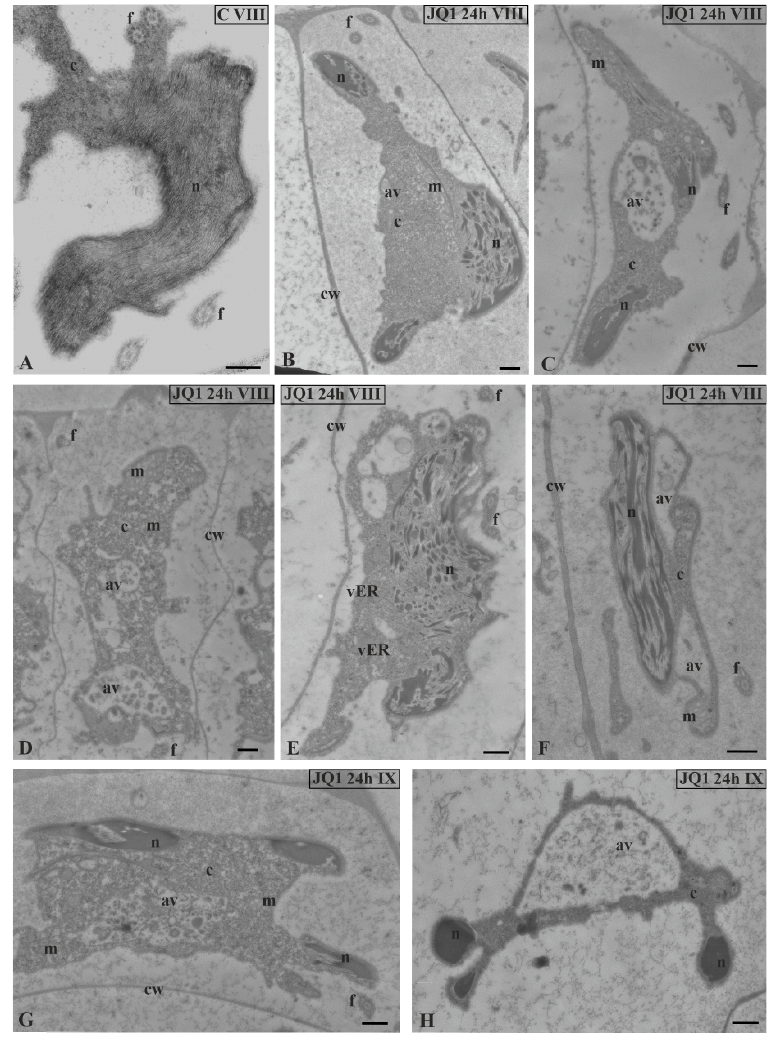
Figure 8. The effect of JQ1 on C. vulgaris spermatid ultrastructure at stages VIII ( B – F ) and IX ( G , H ) after 24-h JQ1 treatment; ( A ) the control, nucleus with long parallel chromatin fibrils; ( B , C , E – G ) disturbances in chromatin structure, and shorter or longer chromatin fibrils in the form of clusters separated by brighter areas; ( C – H ) changes in the cytoplasm area, numerous vesicles and large autolytic vacuoles containing fragments of cytoplasm; ( H ) spermatid with correctly condensed chromatin but with changes in cytoplasm. Longitudinal section of spermatids. Nucleus on cross-section ( H ); av, autolytic vacuole; c, cytoplasm; cw, cell wall; f, flagellum; m, mitochondrion; n, nucleus; vER, endoplasmic reticulum vesicle; on individual images in the frame treatment, time of treatment and stage of spermiogenesis were given; Scale bar = 500